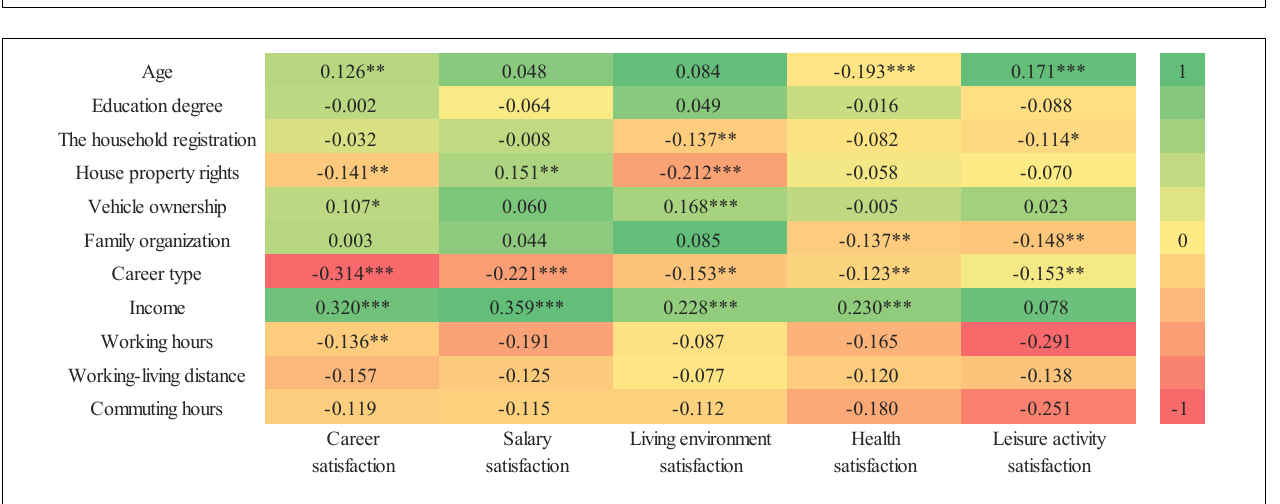
FIGURE 7 | Spearman correlation values of five types of satisfaction. " ∗∗∗ " Means significant at the 0.01 level; " ∗∗ " means significant at the 0.05 level; "*" means significant at the 0.1 level.